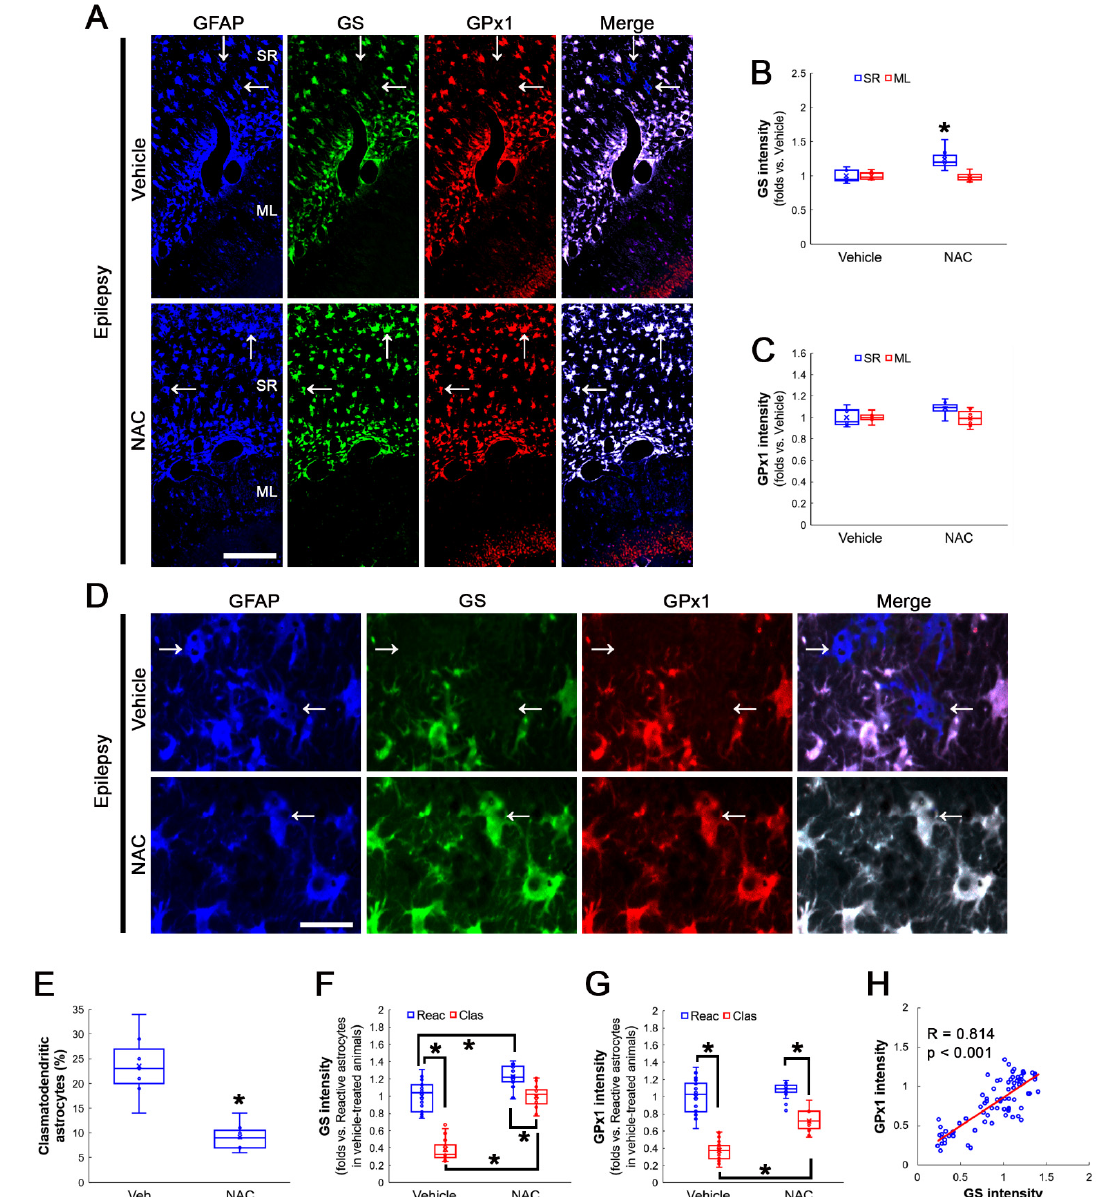
Figure 3. Effects of NAC on GS and GPx1 expressions and clasmatodendritic degeneration of CA1 astrocytes in chronic epilepsy rats. As compared to a vehicle, NAC upregulates GS expression in reactive astrocytes and clasmatodendritic astrocytes within the stratum radiatum (SR) of the CA1 region, while it enhances GPx1 expression only in clasmatodendritic (vacuolized) CA1 astrocytes (arrows). NAC also attenuates clasmatodendrosis in CA1 astrocytes. However, NAC does not affect